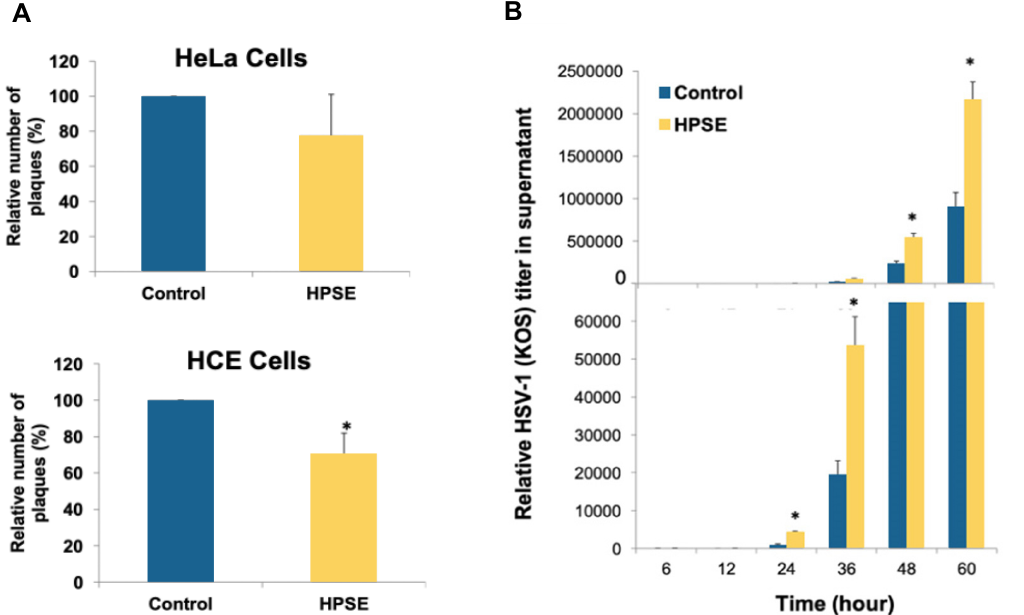
Figure 2. Transient overexpression of HPSE reduces HSV-1 syncytial spread and instead promotes extracellular release. ( A ) HeLa and HCE cells were transfected with either HPSE expression plasmid (HPSE) or with a control empty vector. Then, 24 h post transfection, cells were infected with syncytial plaque-forming HSV-1 (KOS) 804 virus at MOI of 0.001. Four to 5 days post infection, cells were fixed and stained with crystal violet stain. Infectivity was measured by the number of plaque-forming units (PFUs). Results are means ± 1 SD of at least three independent experiments conducted in duplicate. (* p < 0.05). ( B ) HeLa cells were transfected with either HPSE expression plasmid (HPSE) or with a control empty vector. Then, 24 h post transfection, cells were infected with HSV-1 (KOS) for 2 h. After 2 h, cells were washed, and growth medium was added back to the cells. At time points: 6, 12, 24, 36, 48, and 60 h post infection, HSV-1 release from infected cells was examined by tittering 100 µ L from the culture supernatant using plaque assay on Vero cells. A representative graph of two independent experiments conducted in duplicate is shown. (* p < 0.05).